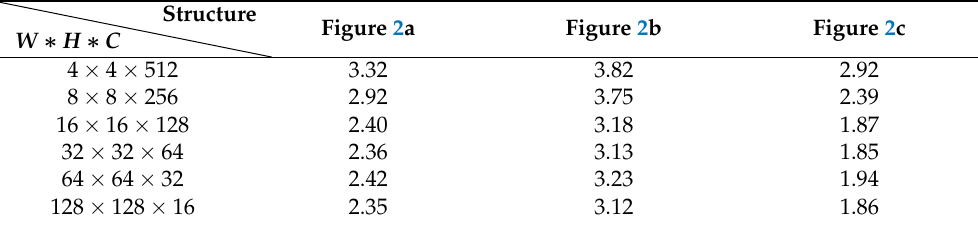
Table 1. The comparison of three basic structures. Each structure is stacked ten times. The total times of the three structures are listed, which are tested for 1000 rounds under various inputs and outputs of dimensions W ∗ H ∗ C .